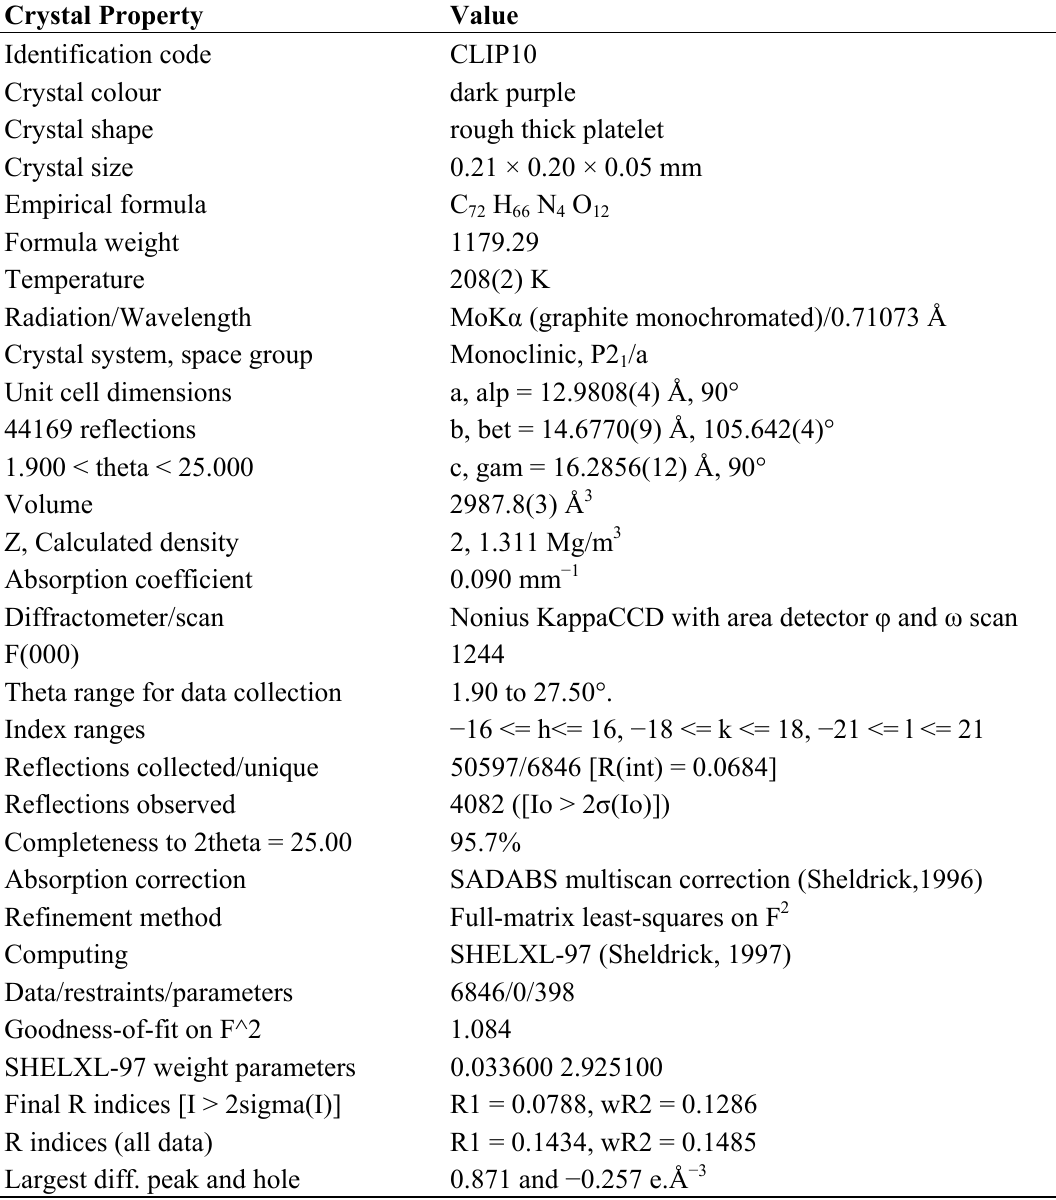
Table 5. Crystallographic data for isomer S